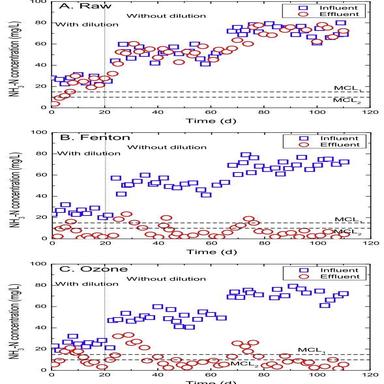
The NH3-N concentration of raw (A), Fenton- (B), and ozone-pretreated (C) wastewater in SBR system.